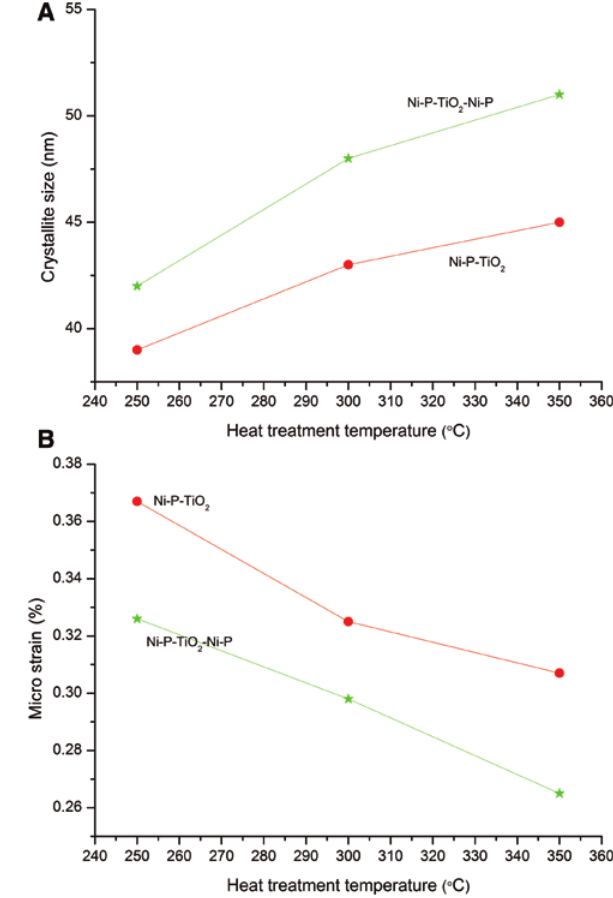
composite coating heat 2 -Ni-P multilayer 2